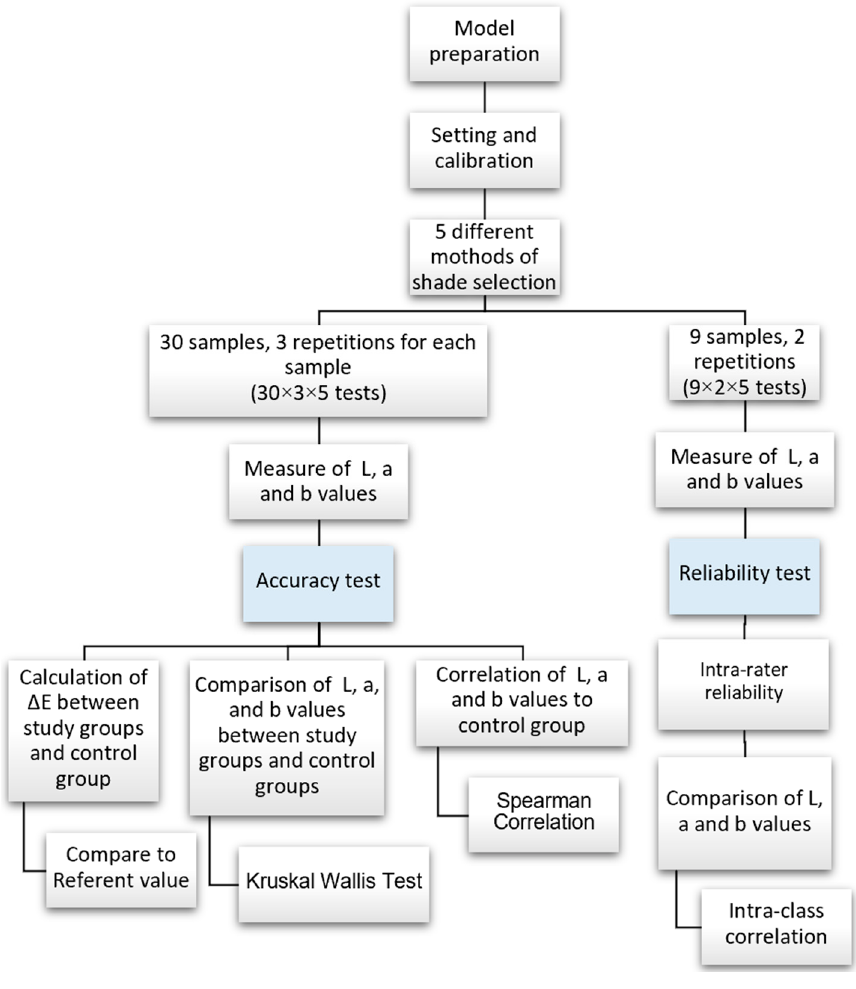
Figure 1. Overview of the study.